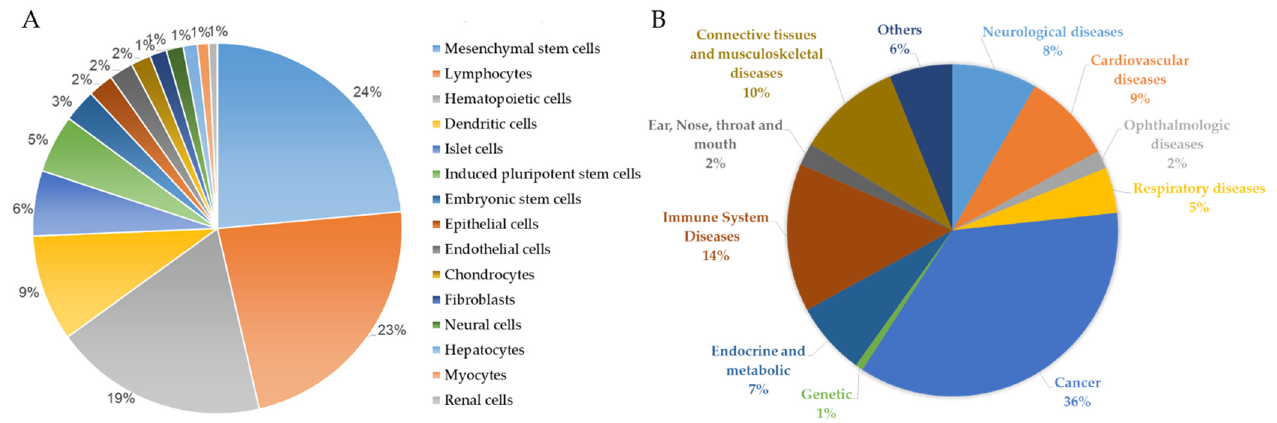
Figure 1. Frequency distribution of recruiting, completed, and enrolling cell-based clinical trials in the past decade. ( A ) Pie chart showing the relative frequency distribution of clinical trials using indicated cell type. ( B ) Pie chart showing the relative frequency distribution of clinical trials for indicated diseases (from URL https://clinicaltrials.gov/ , accessed on 16 August 2022).